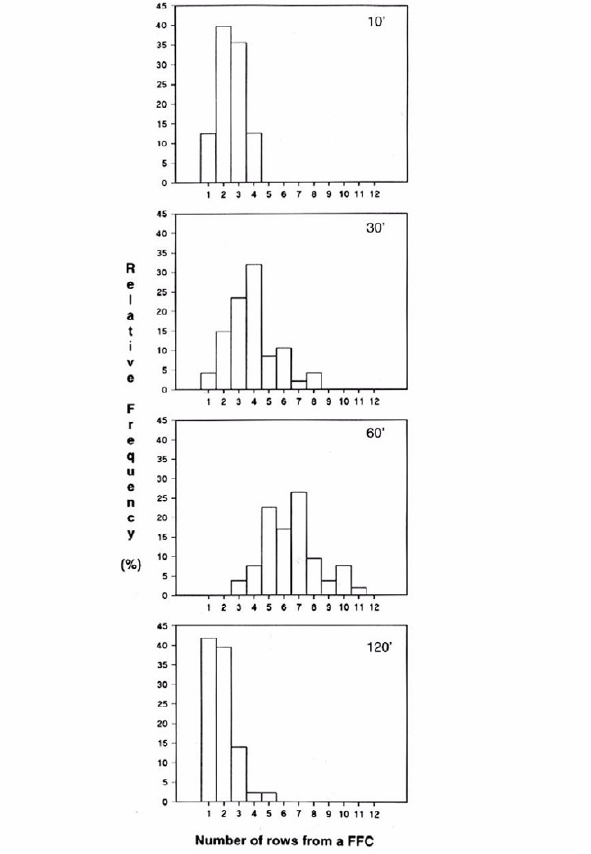
rows connected to one FFC after 10, 30, 60 and 120 static whole-mount TEM images of Figure 7 . From